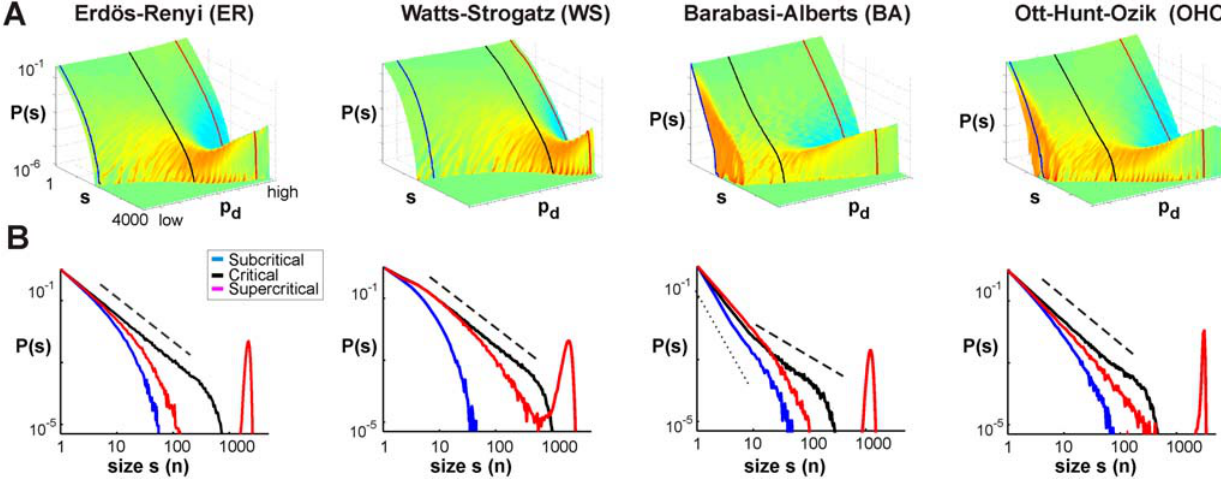
Figure 2. Cascade size distributions obtained from simulations of subcritical, critical, and supercritical branching process dynamics on different network topologies. (A) 3D plots of the avalanche size distributions ranging from the subcritical (low p d , front) to supercritical (high p d , back) dynamics of the branching processes simulated on 4 different network topologies with N ~ 5000, S k d T ~ 10 for OHO S k d T ~ 12 ð Þ . The link probability p d is constant for all links, and served as a control parameter for different dynamical regimes. (B) Size distributions for all 4 topologies at three particular values of p d , subcritical (blue), critical (black), and supercritical (red) regimes (see the indicated cross-sections in (A)). The distribution of avalanche sizes s in the critical branching process regime follows a power law with slope of 2 3/2 (dashed line). A clear critical point is observed for ER and WN networks, while for OHO and BA a power law was observed only for a portion of the size values but not for the full range.